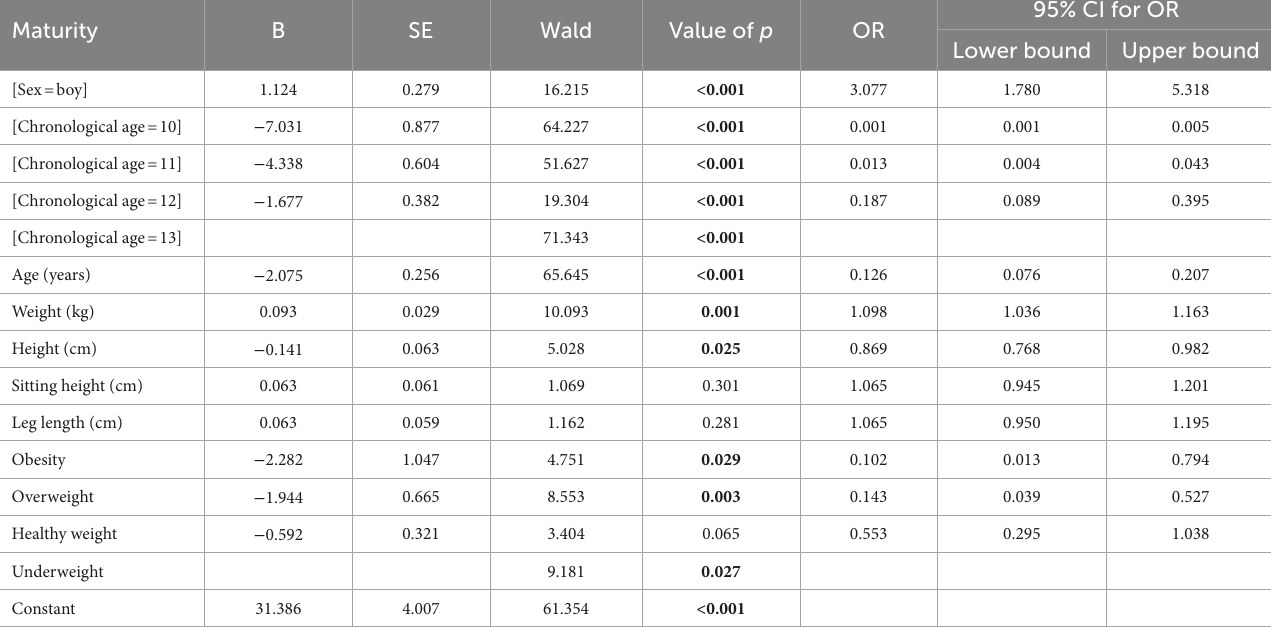
TABLE 6 Logistic regression results.